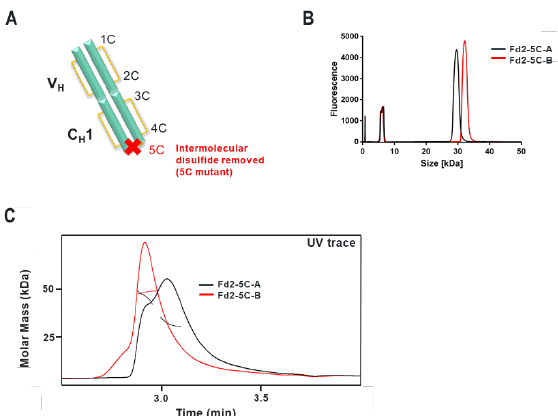
Figure 4. Representation of the Fd2-5C dimer variant and experimental data for both Fd2-5C-A and Fd2-5C–B molecules. ( A ) Representation of the dimeric Fd2 domain in cyan, with the V H and C H 1 regions labeled and segmented. Each disulfide bond is represented in yellow, and the location of each cysteine is labeled for one Fd domain (1C-5C counting from the N-terminus). The intermolecular disulfide bond connected by the 5C cysteines is removed by cysteine to serine mutagenesis and thus marked with a red “X”. ( B ) Overlaid NR-cSDS electropherograms for both Fd2-5C-A (black trace) and Fd2-5C-B (red trace) and ( C ) Overlaid SEC-MALS profiles for both Fd2-5C-A (black trace) and Fd2-5C- B (red trace). Results are plotted as molar mass (kDa) versus time with each chromatogram generated by UV absorption. Measured molar masses are overlaid on each chromatogram (Fd2-5C-A in black and Fd2-5C-B in red).